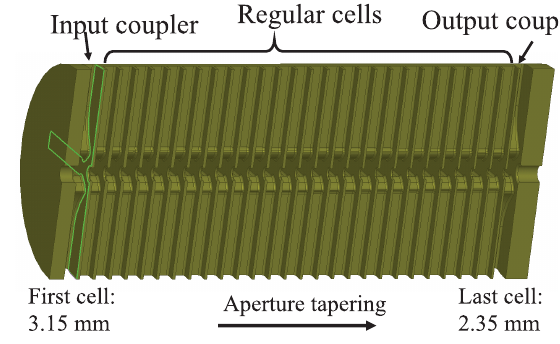
FIG. 11. Sketch of CLIC accelerating